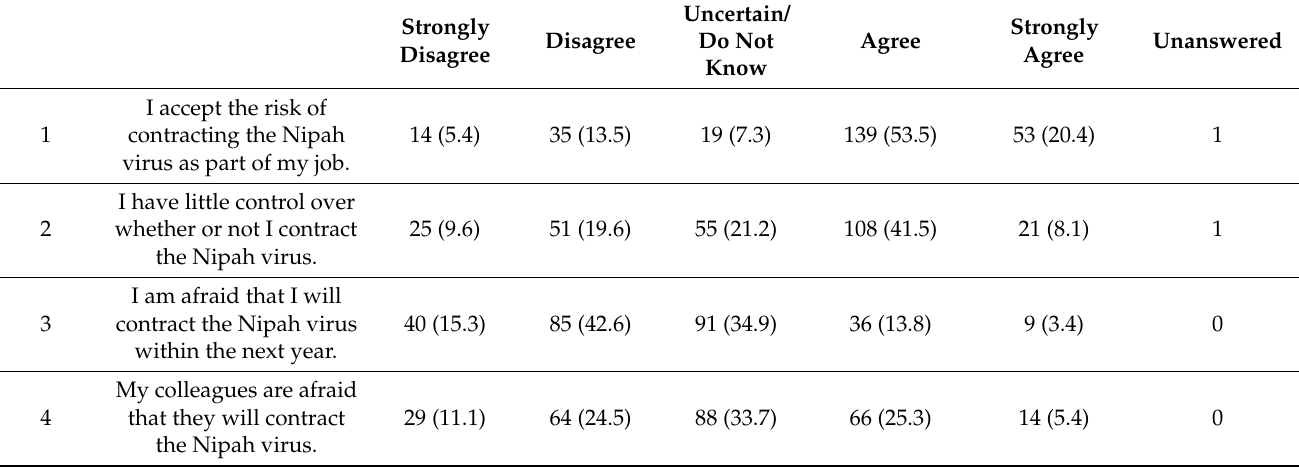
Table 6. Risk Perception of Nipah virus infection.